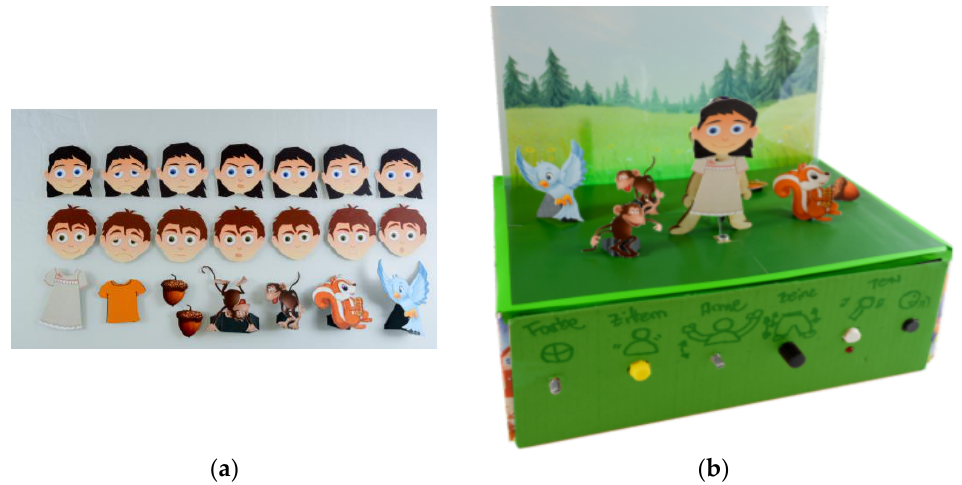
Figure 37. Interchangeable emotional faces, characters, and objects ( a ), interactive diarama for sup- porting storytelling ( b ) [69].